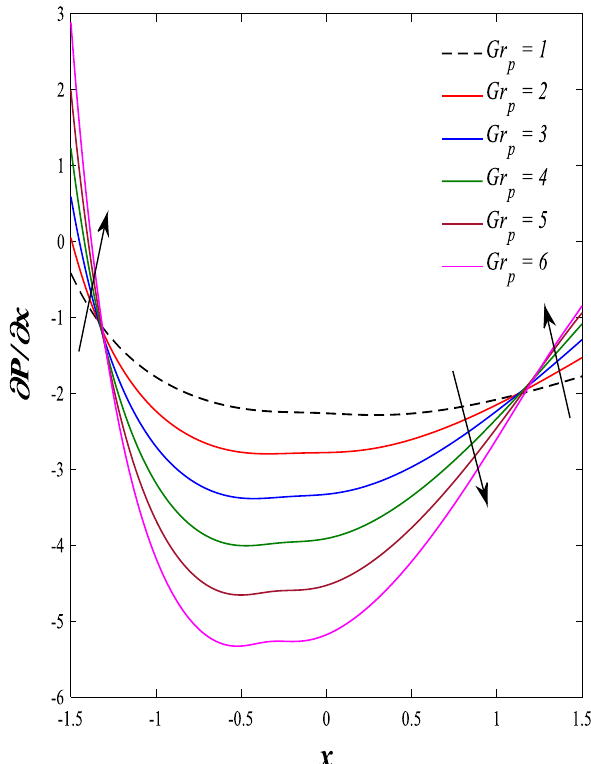
Figure 28. Effect of nanoparticles Grashof number Gr p on the pressure gradients distribution.